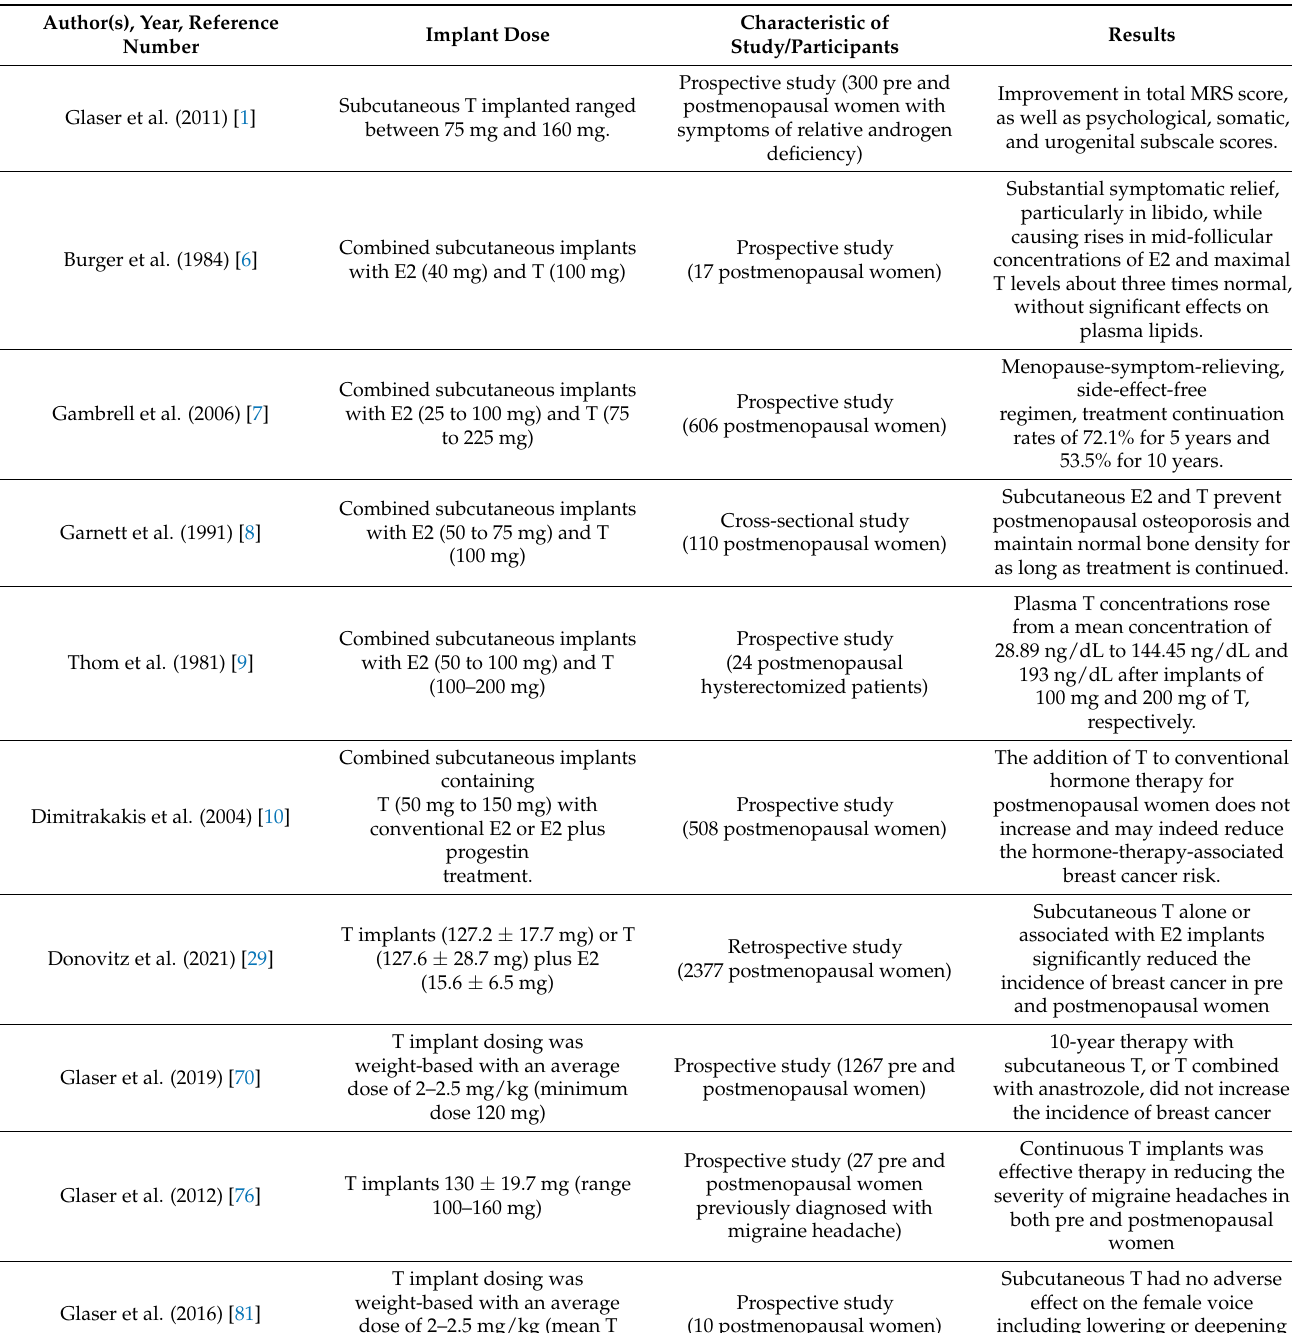
Table 1. Safety and benefits of STT in women. MRS: Menopause Rating Scale, T: testosterone, E2: